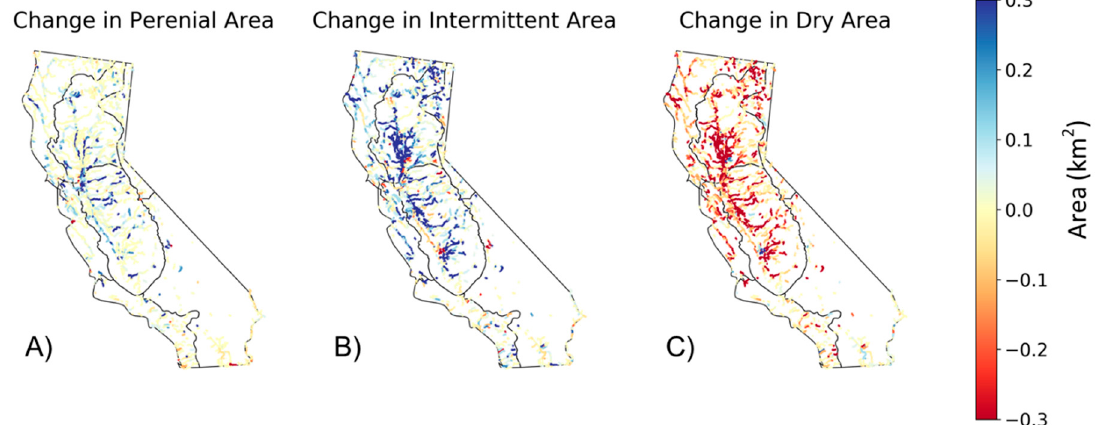
Figure 6. ( A ) Change of perennial, ( B ) intermittent, and ( C ) dry area of 2017 river reaches in post-drought year 2017 com-pared to during-drought year 2014.